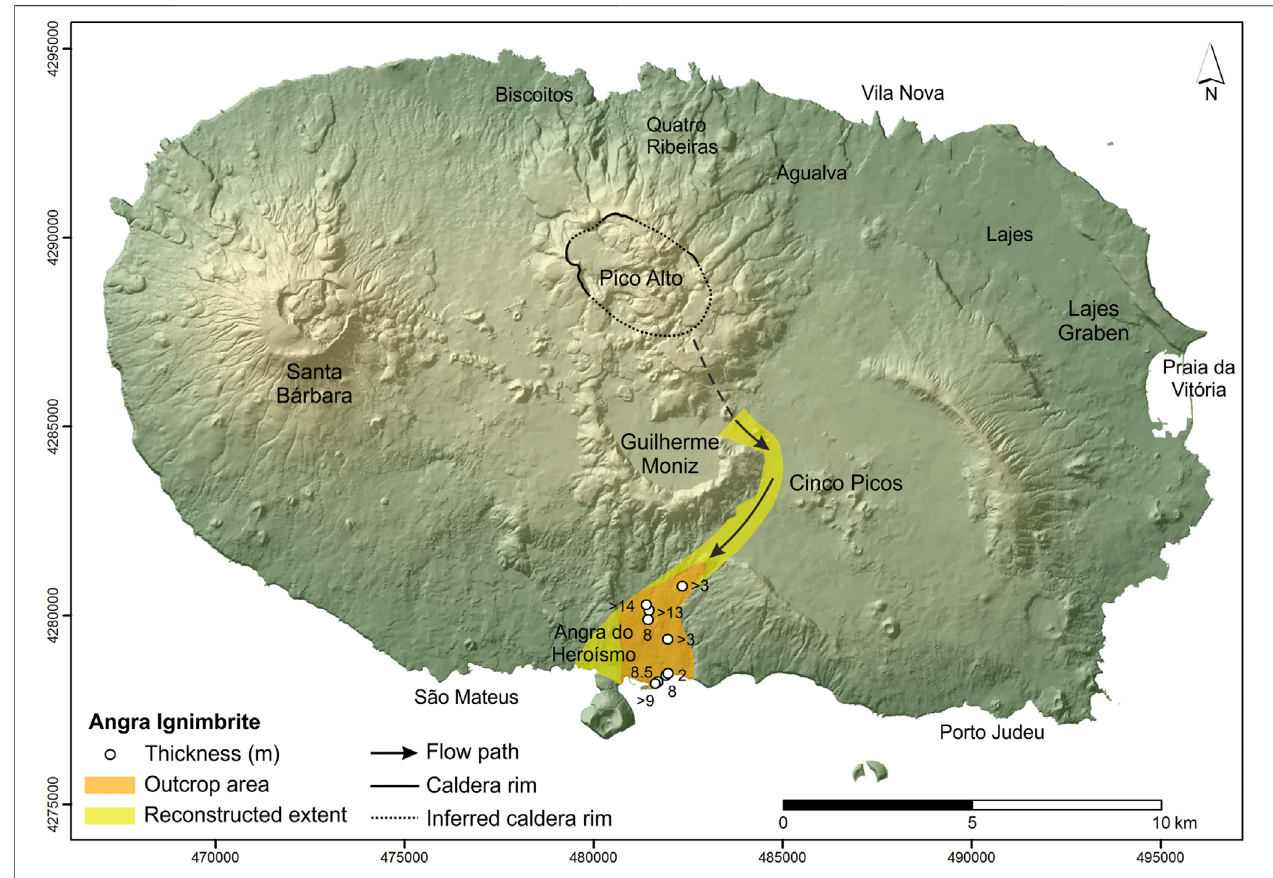
FIGURE 3 | Distribution map of the Angra Ignimbrite, including documented stratigraphic sections (white circles). Arrows indicate main fl ow paths; Locality names referred throughout the text are shown; UTM coordinates, zone 26S.